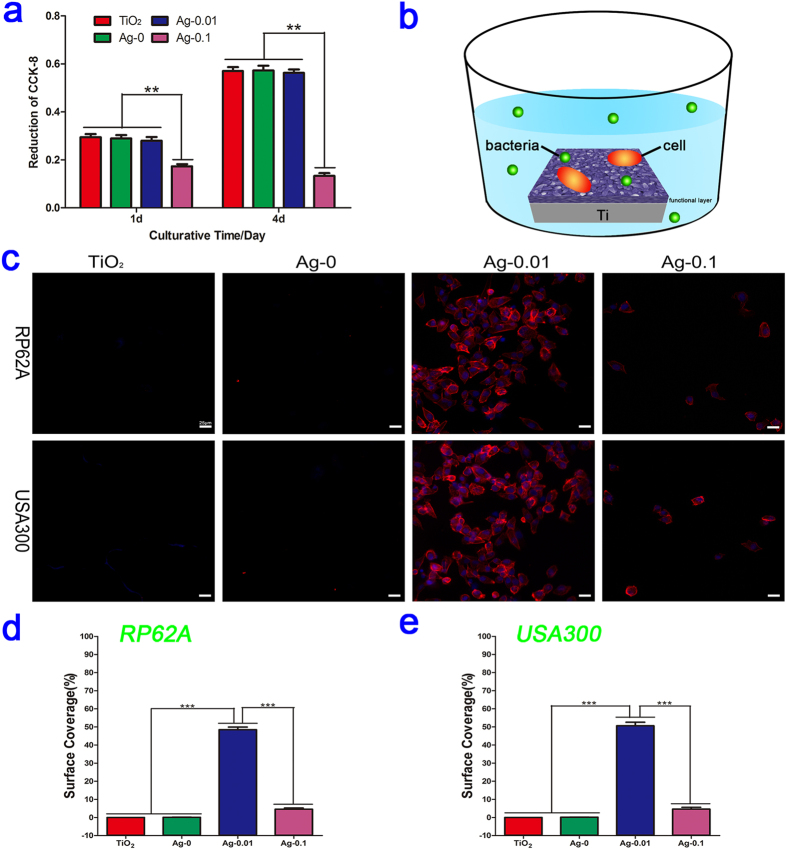
Cytotoxicity test and antibacterial assessment in a bacteria-fibroblast co-culture system.(a) Results of a CCK-8 assay showing the cytocompatibility for HT1080 cells cultured on micro-arc-oxidized TiO2 coatings with and without Ag doping. **P <  0.01 vs the Ag-0.1 group. (b) Schematic illustration of the co-culturing process for the fibroblasts, bacteria and samples. (c) Fluorescent images of fibroblast cells on four different specimens contaminated with PR62A or USA300 after staining with DAPI (blue) and TRITC-phalloidin (red). (d–e) The corresponding surface coverages of the four samples contaminated with RP62A or USA300. ***P < 0.001.